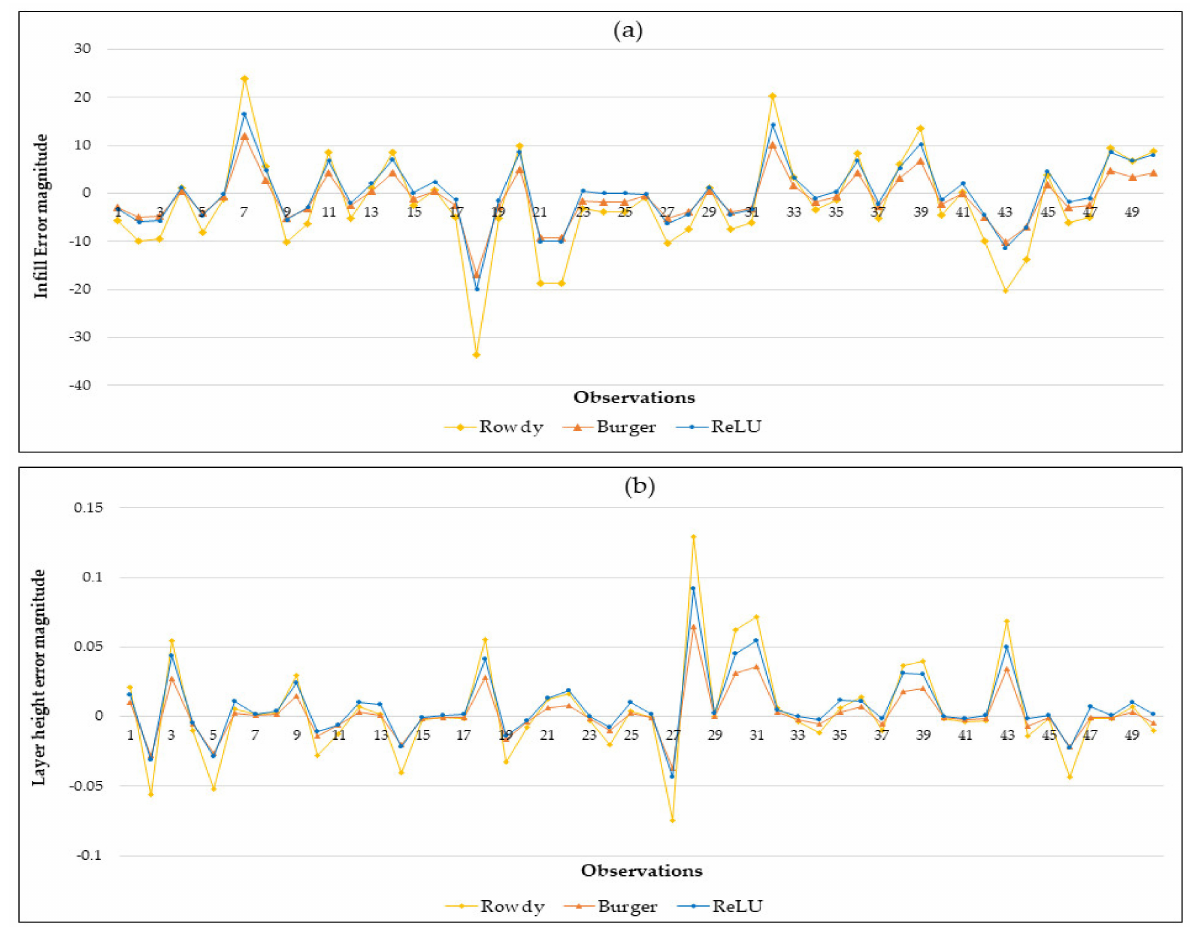
Figure 18. Error magnitude with adaptive functions for data predictions: ( a ) infill; ( b ) layer